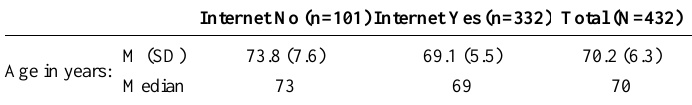
Table 2. Descriptive statistics of the variable Age separated with Internet use